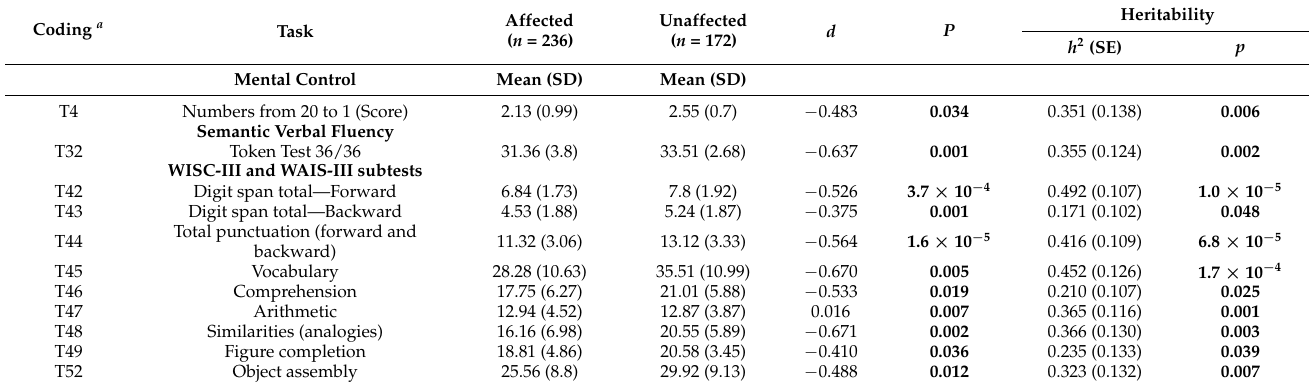
Table 1. ADHD cognitive endophenotypes in 408 individuals belonging to 113 nuclear families from Barranquilla, Colombia. Coding